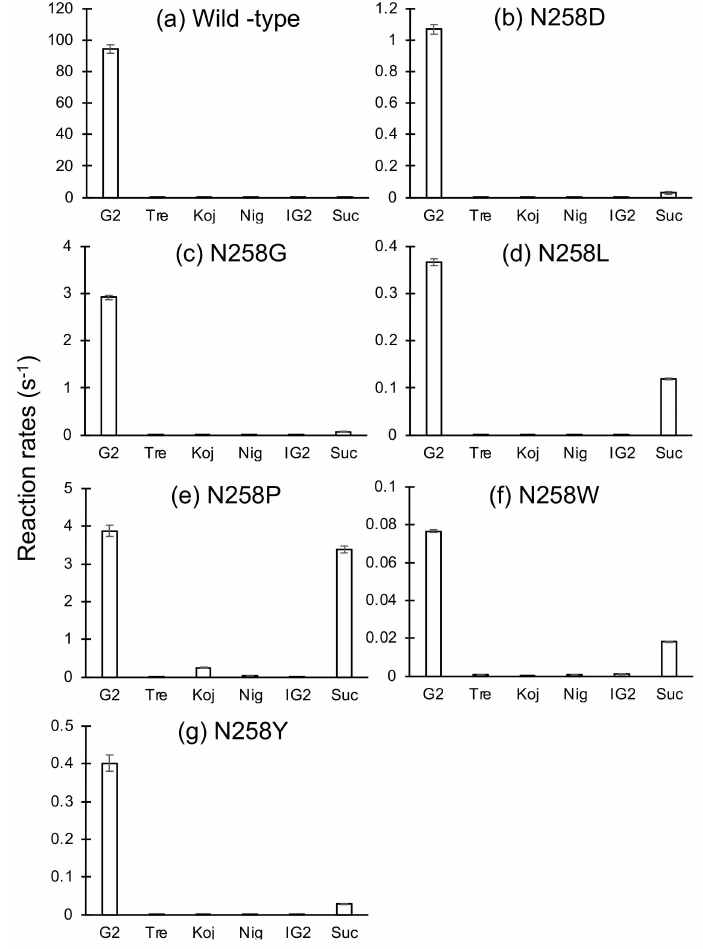
Figure 2. Reaction rates of Asn258 mutants of BspAG13_31A. ( a ) Wild type, ( b ) N258D, ( c ) N258G, ( d ) N258L, ( e ) N258P, ( f ) N258W, and ( g ) N258Y. Reaction rates to 1 mM substrates are shown. Values are the average ± standard deviation from three independent experiments. Panel ( a ) was made using data from reference